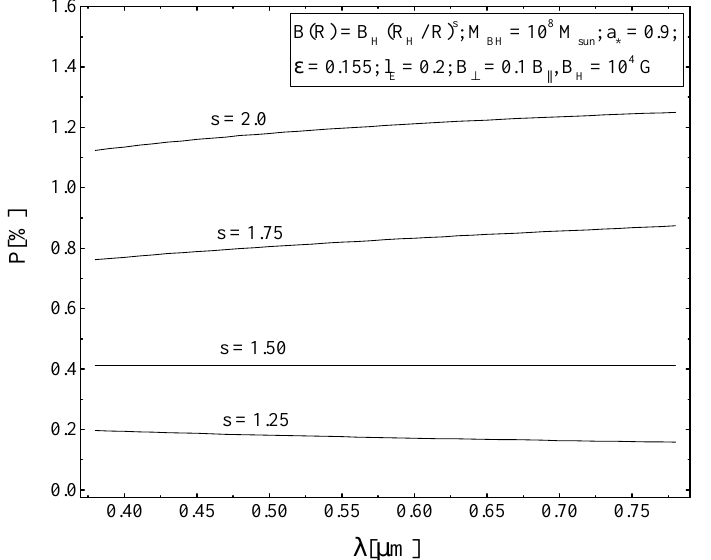
Figure 3. Dependence of the degree of polarization P on the wavelength λ for different values of the parameter s .